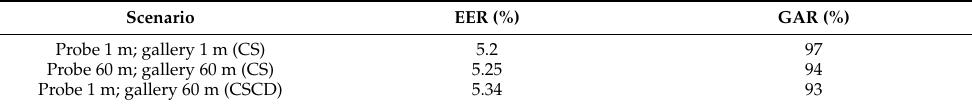
Table 2. The performances of CS and CSCD matching using homomorphic